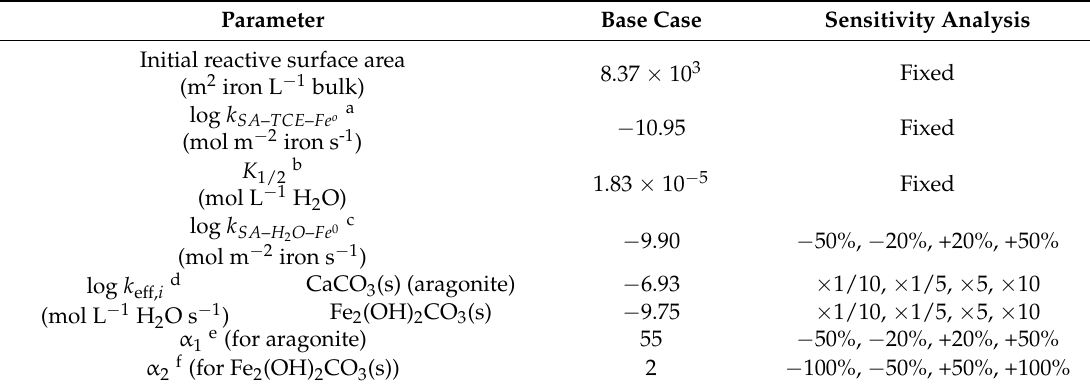
Table 2. The parameter values for the base case and range tested for each